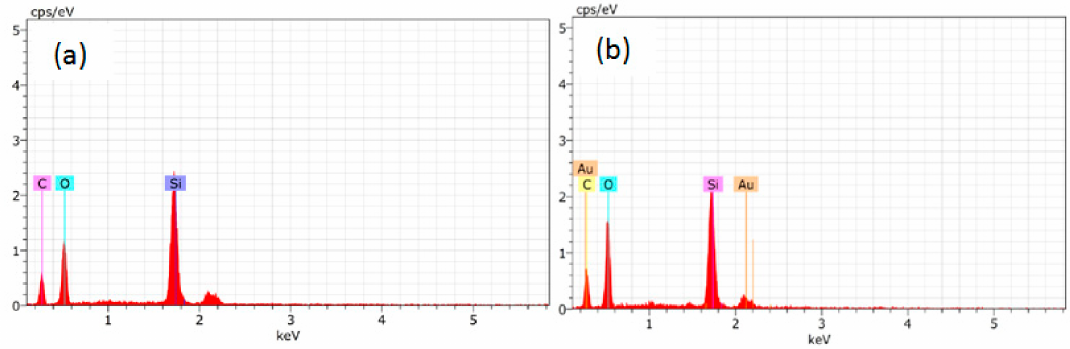
Figure 11. EDS Spectra for ( a ) SR1 and ( b ) SR3 composition after wear